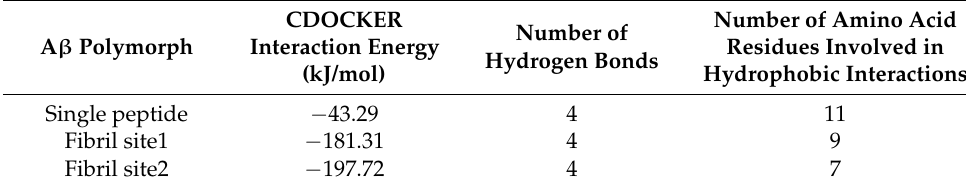
Figure 2. The interaction between Cy-3G and the A β fibril. ( a ) The two binding sites between Cy-3G and a disease-relevant A β fibril. The cartoon representation is the A β fibril structure, and the pink stick presentation is the Cy-3G molecule. The first binding site is the hydrophobic core of one fibril stack, and the other binding site is on the opposite side of the hydrophobic site. ( b , c ) are the interaction details between Cy-3G and the first and second binding sites. The dashed lines represent hydrogen bonding, and amino acid residues involved in hydrophobic interactions were shown. For example, F4(E) indicates the fourth phenylalanine in Chain E of the A β fibril. Table 1. Binding parameters of Cy-3G to different A β